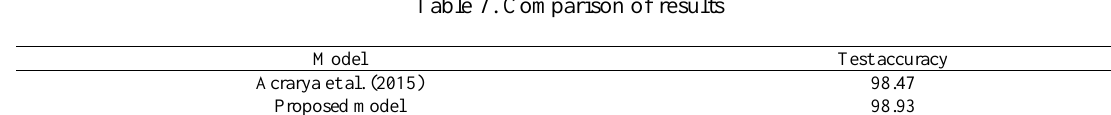
Table 7. Comparison of